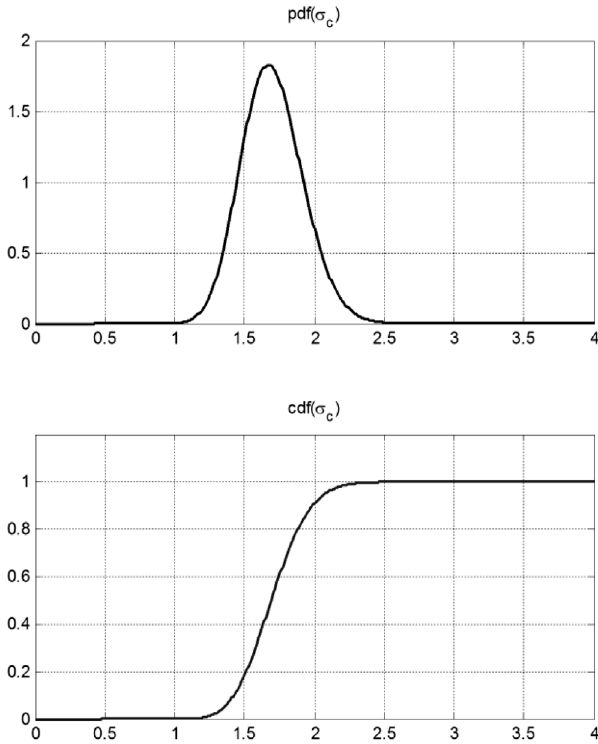
Fig. 20. Probability density function (top) and cumulative distribution function (bottom) for failure stress s c expressed in